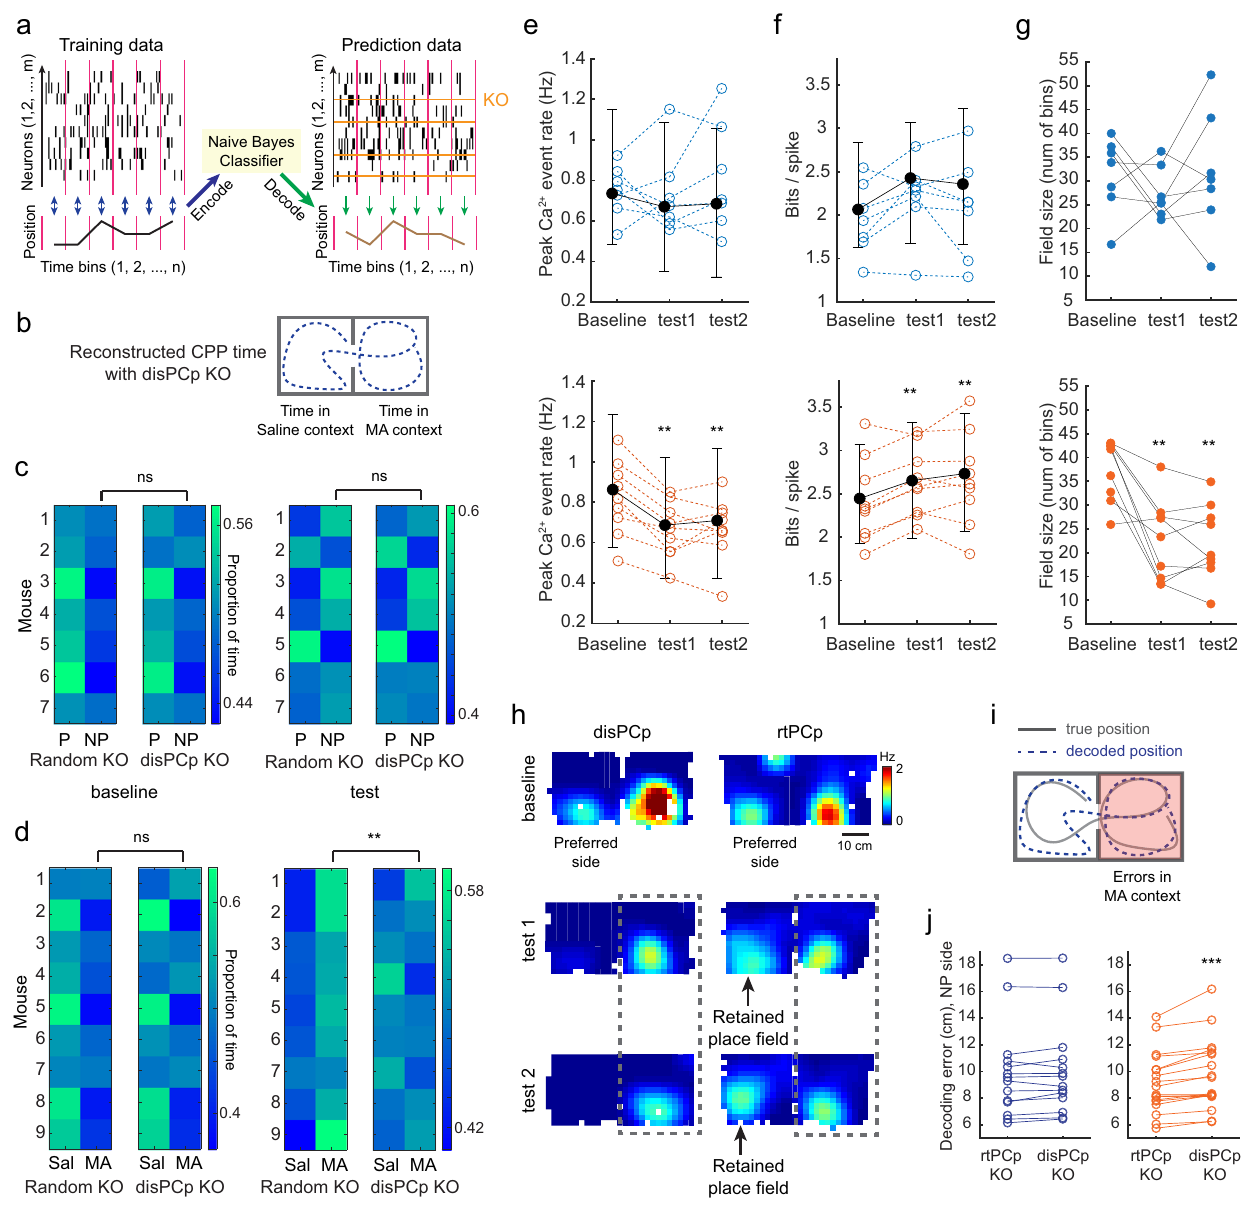
Fig. 4 | disPCp contribute to the encoding of MA-paired context after con- ditioning. a Schematic of the knock-out (KO) decoding method. b Evaluating the decoding performance using reconstructed CPP time. c Reconstructed CPP time with disPCp vs. random neuron KO in Ctrl mice. Each row is a mouse and each column representsa CPPcontext(P: preferred, NP: non-preferred).Brighter colors indicate a larger proportion of time. Left, baseline analyses ( p =0.08, n =7 mice, two-tailed sign-rank test). Right, test analyses ( p =0.11, n =7 mice, two-tailed sign- rank test). ns, not signi fi cant. d Organized as in ( c ), for MA mice. Baseline analyses ( p =0.2, n =9mice,two-tailedsign-ranktest).Testanalyses( p =0.0039, n =9mice, two-tailed sign-rank test). See results. e – g Place fi eld properties of disPCp in MA- pairedcontextforCtrl(blue)andMA(orange)mice. e Peakcalciumeventrate:Ctrl (baselinevs.test1: p =0.81;baselinevs.test2: p =0.81, n =7mice);MA(baselinevs.